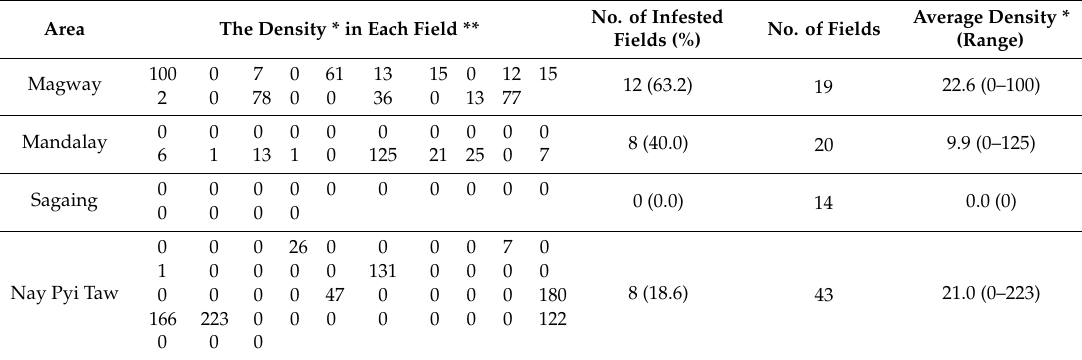
0 * The density was expressed as eggs equivalent 20 g soil − 1 . ** Light gray means the fields detected.